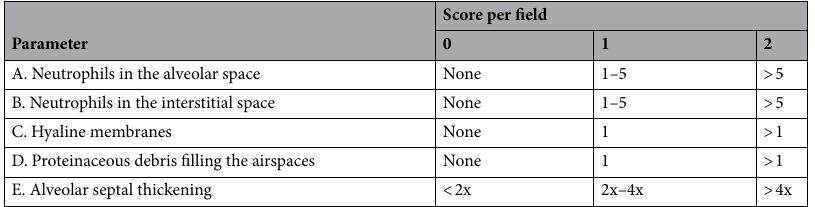
Table 2. Histological scoring of lung sections. The score for each animal was calculated as follows = [(20 × A) + (14 × B) + (7 × C) + (7 × D) + (2 × E)]/(number of fields × 100).